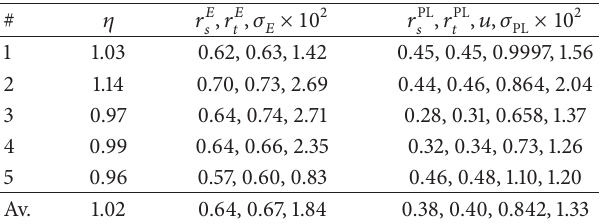
Figure 2: 2D correlation function 𝜁(𝑠,𝑡) for the Patch 5 (light blue surface). All axes are in units of 𝑙 0 , (3). The darker surface is given by the best fit for 𝜁(𝑠,𝑡) by an isotropic exponential fitting function ) with 𝑟 = √𝑠 2 + 𝑡 2 . The best fitting values 𝜁(𝑟) = 𝜁(0, 0) exp (−𝑟/𝑟 𝐸 of the correlation radius 𝑟 𝐸 are summarized in Tables 1 and 2 for all five patches. Table 1: The parameterization of the extracted correlation functions 𝜁(𝑠,𝑡) by anisotropic exponential and power law fitting functions, (6). Rows 1–5 give the data for the individual patches and the last row for the correlation function averaged over all